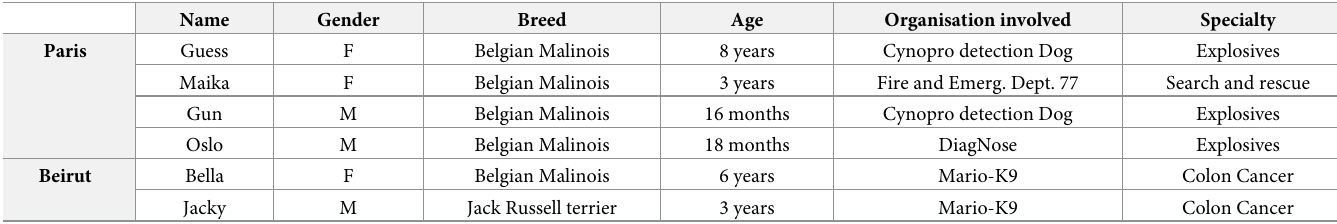
Table 1. Characteristics of the 6 dogs participating in the study testing